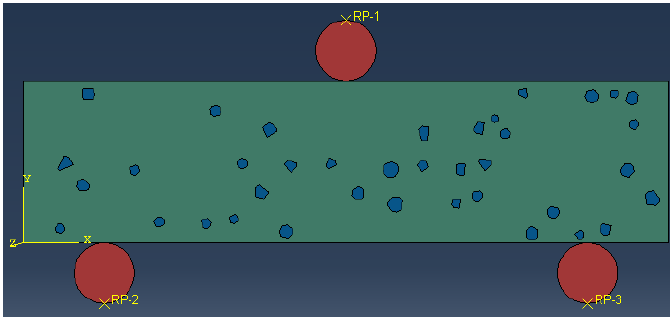
Figure 23. Rubber particles in a 2D CRM6 sample.